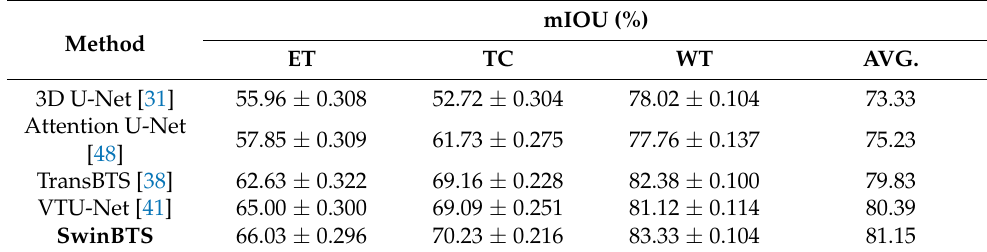
Table 2. Segmentation mIOU results on BraTS 2019 test